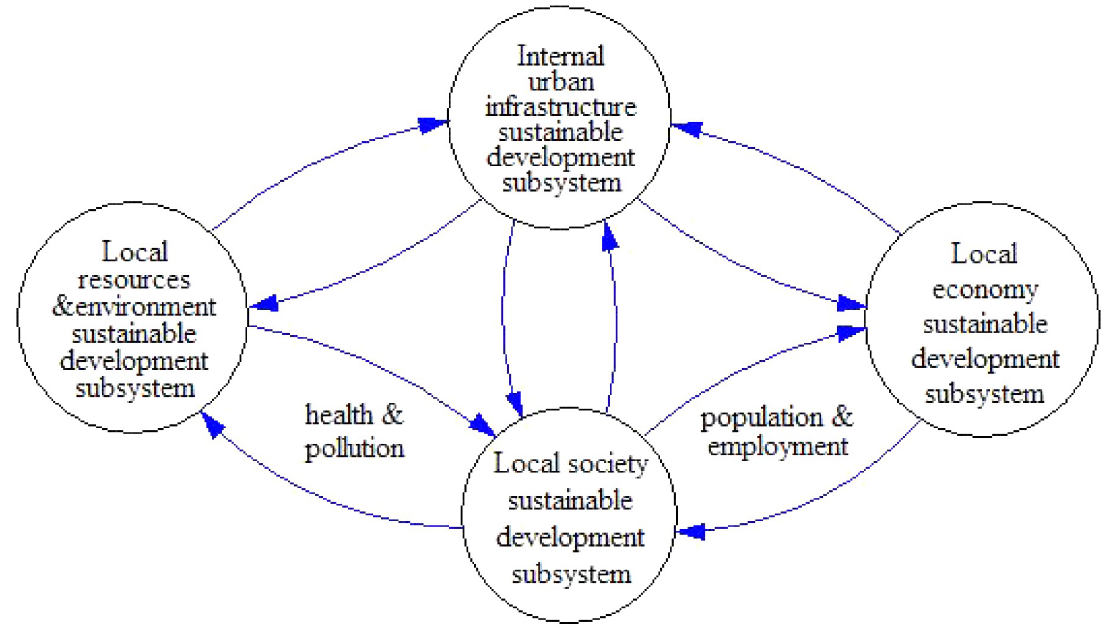
Figure 3. The causality between four urban infrastructure sustainable development